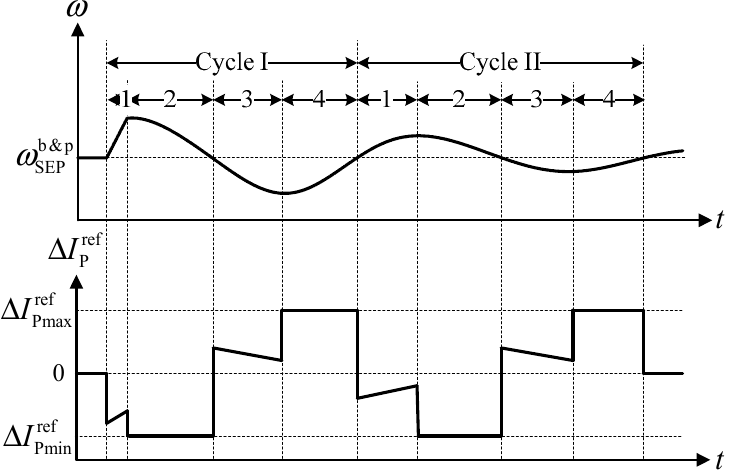
Figure 6. Schematic diagram of the control actions of the proposed controller in different stages.